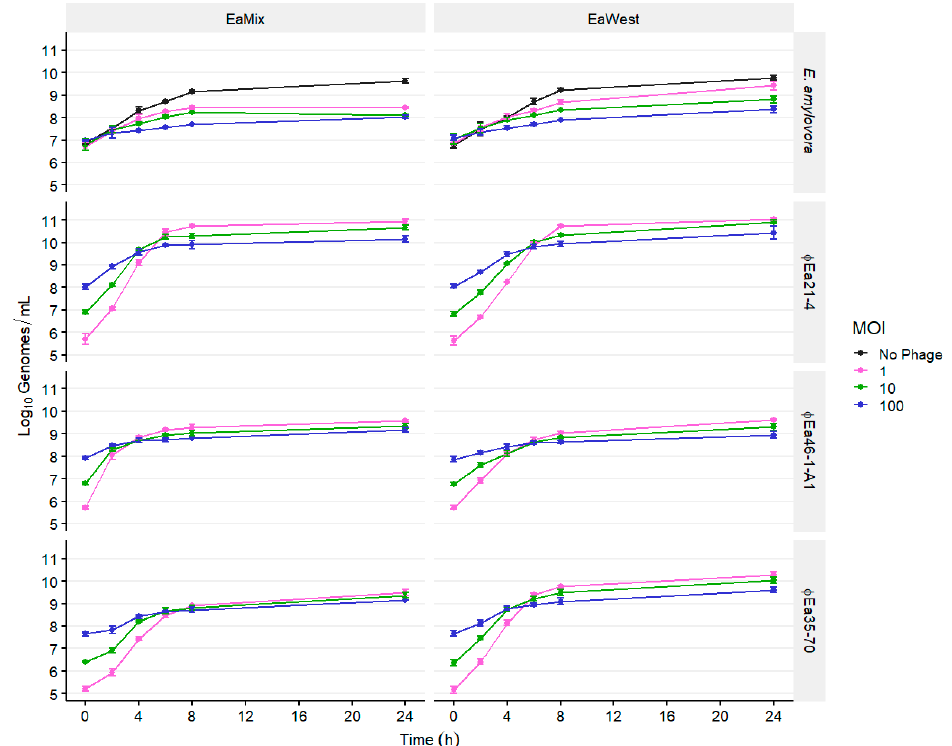
Figure 2. Populations over time of E. amylovora cultures infected with the three-phage cocktail at different starting multiplicities of infections (MOIs). The infected cultures were an equal combination of Ea17-1-1 and EaD7 (EaMix), and 20060013 and 20070126 (EaWest), and are indicated in the top banners. The banners on the right indicate the host or phage quantified. Each culture was infected simultaneously by the phages ϕ Ea21-4, ϕ Ea46-1-A1, and ϕ Ea35-70, each at the indicated MOI. Genomic titers of E. amylovora and each phage were determined with qPCR. Data are the mean ± SD of three replicates.